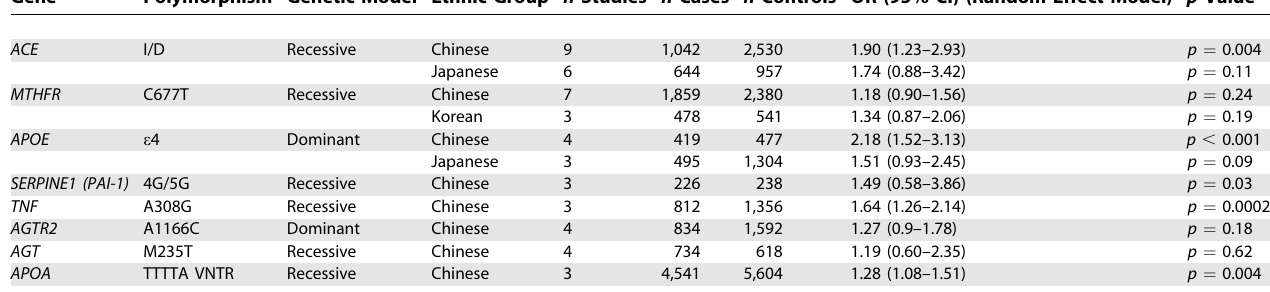
Table 1. Summary of Candidate Genes in Ischemic Stroke Evaluated in Persons of Non-European Descent Gene